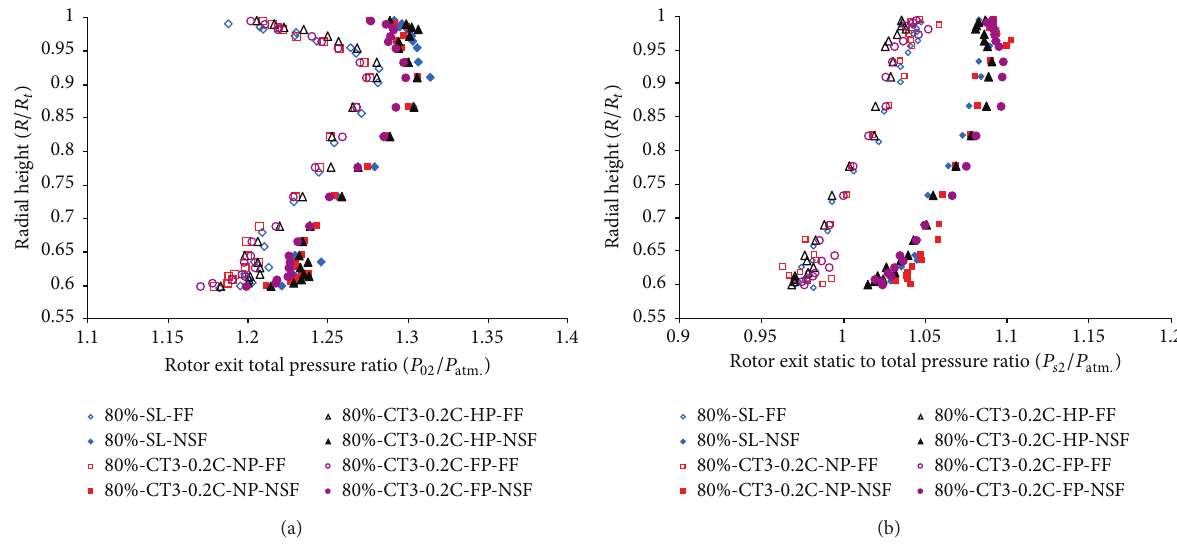
Figure 12: Comparative variations of (a) rotorexit total and (b) static pressurefor thesolid casing and three configurations of casing treatment and plenum chamber at full flow (FF) and near stall flow (NSF)